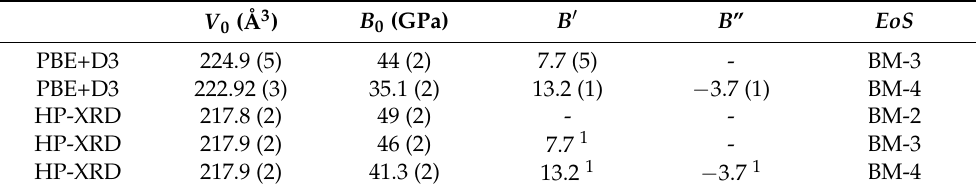
Table 1. Zero-pressure volume ( V 0 ), bulk modulus ( B 0 ) and the corresponding pressure derivatives ( B (cid:48) and B ”) for 1T-ReS 2 as obtained by DFT calculations including vdW corrections (PBE + D3) and by HP-XRD measurements. The theoretical and experimental data were fitted using 3rd-order (BM-3) or 4th-order Birch–Murnaghan (BM-4) equations of states